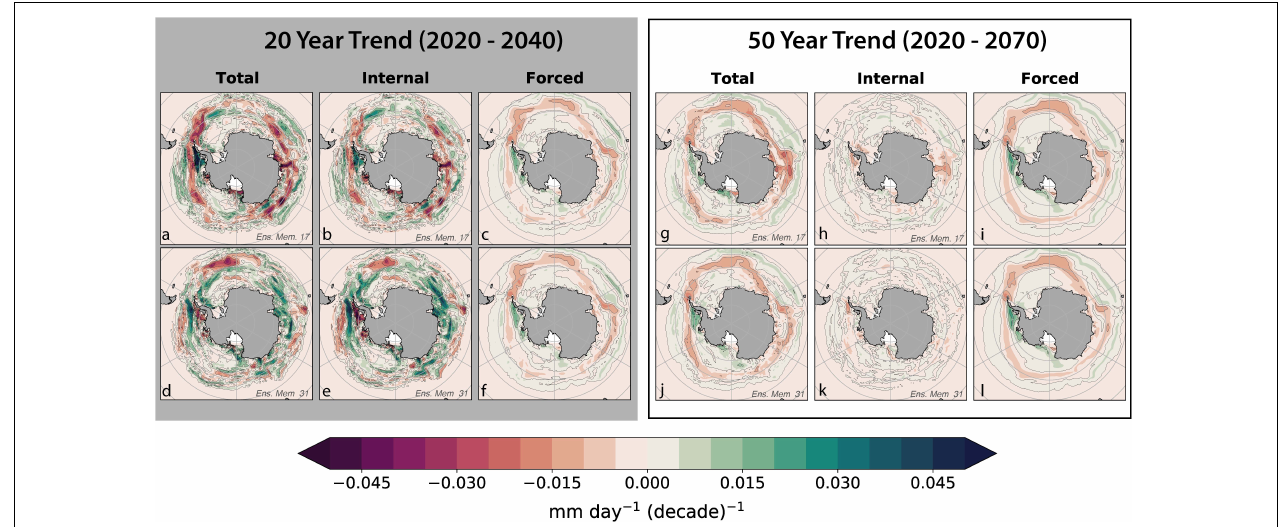
FIGURE 5 | This figure demonstrates the superposition of forced signal and internal variability on the total 20- and 50-year trends of krill GP in austral summer beginning in 2020. Each row is from a separate ensemble member; the top row of plots (a–c and g–i) are from ensemble member 17 while the bottom row of plots (d–f and j–l) are from member number 31. These two ensemble members were chosen as exemplary representations from the ensemble. Plot (a,d) show the total linear trend in GP for the 20-year while plots (g,j) show the 50-year total linear trend. Plots (b,e) show the internal variability within the 20-year trend and plots (h,k) show the 50-year trend. The forced trend (ensemble mean) of the 20-year trend is shown in plot (c) and replicated in (f) and the 50-year forced trend is shown in plot (i) and replicated in (l) . The forced trends are similar between both trend lengths but only drive the spatial coherence in the 50-year total trend, not the 20-year